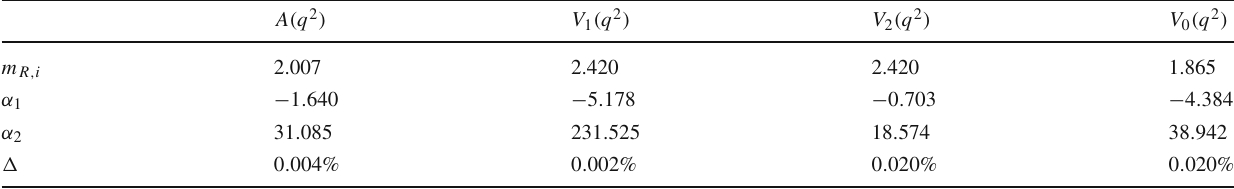
Table 5 The masses of low-lying D resonances, coefficients α 1 , 2 and (cid:24) for the TFFs A ( q 2 ), V 1 ( q 2 ), V 2 ( q 2 ), V 0 ( q 2 ) , in which all the input parameters are set to be their central values